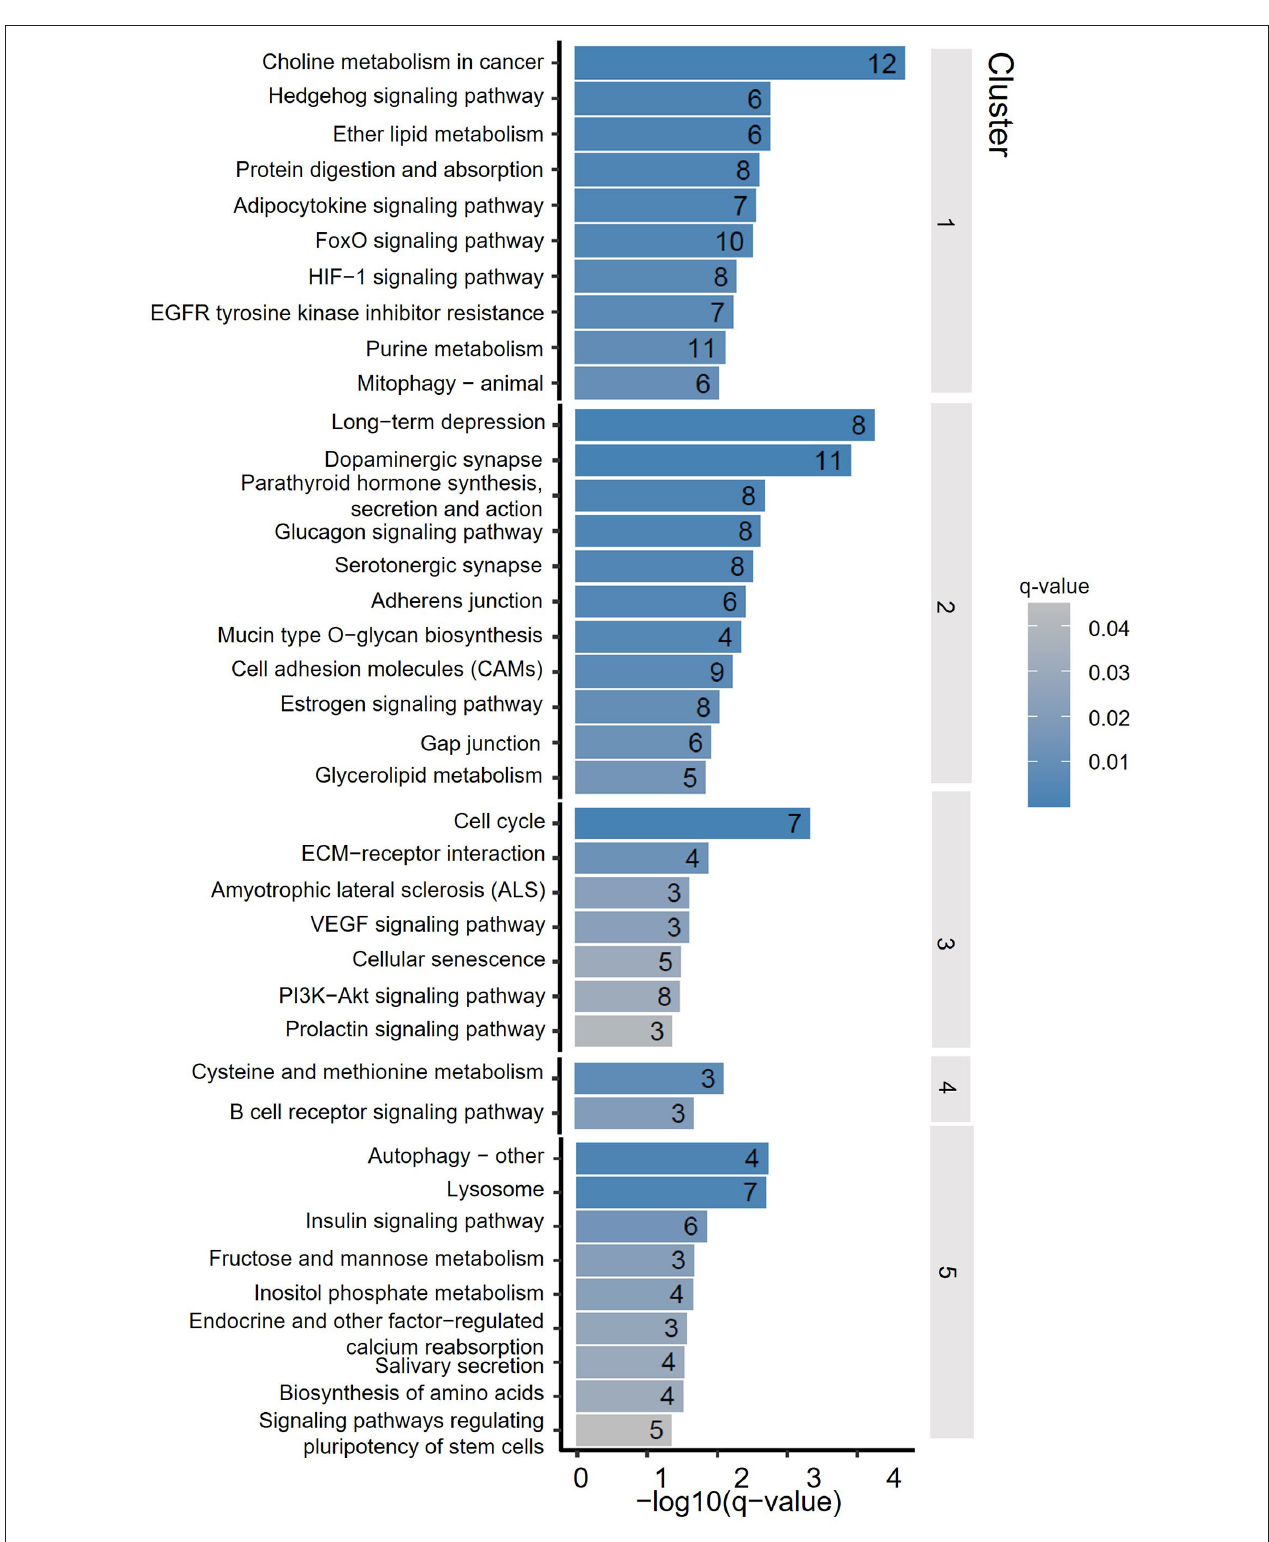
FIGURE 5 | Kyoto Encyclopedia of Genes and Genomes (KEGG) terms of DhMRs from 5 clusters. The y-axis lists the KEGG terms, and the x-axis indicated the significance q-value of enrichment.